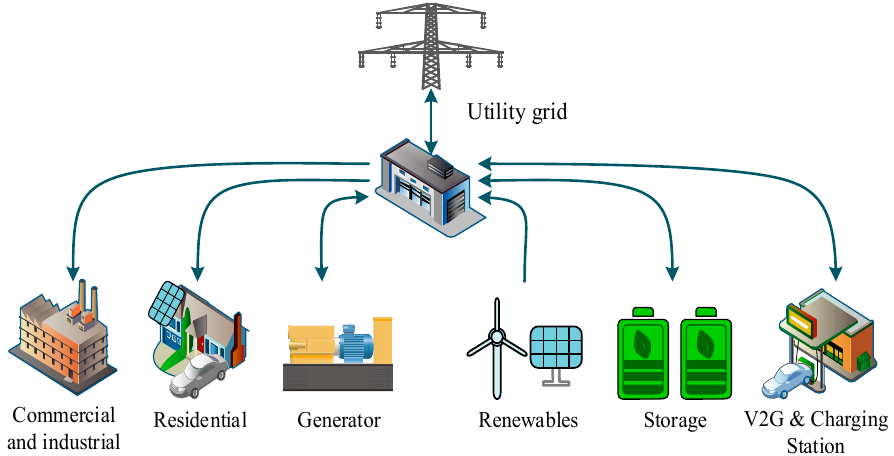
Figure 1. Architecture of a typical microgrid system.